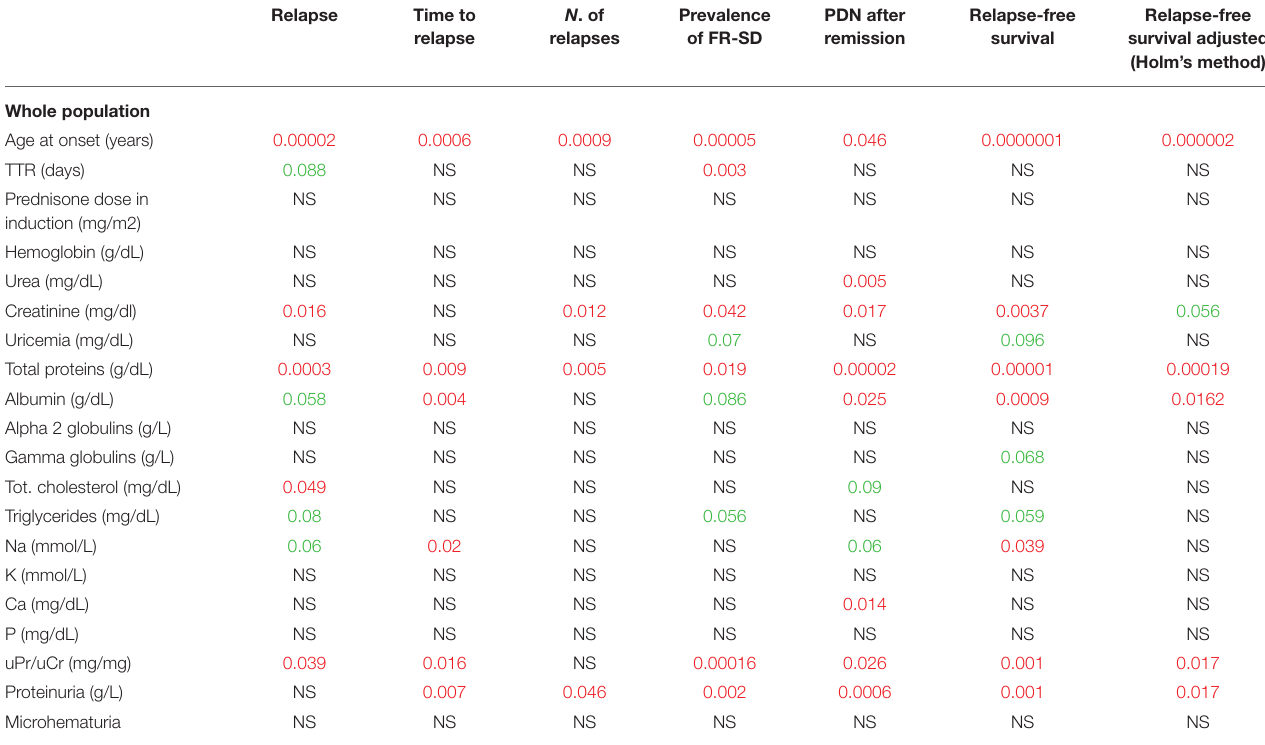
TABLE 2 | Prognostic factors evaluated in the whole population according to the different outcomes.